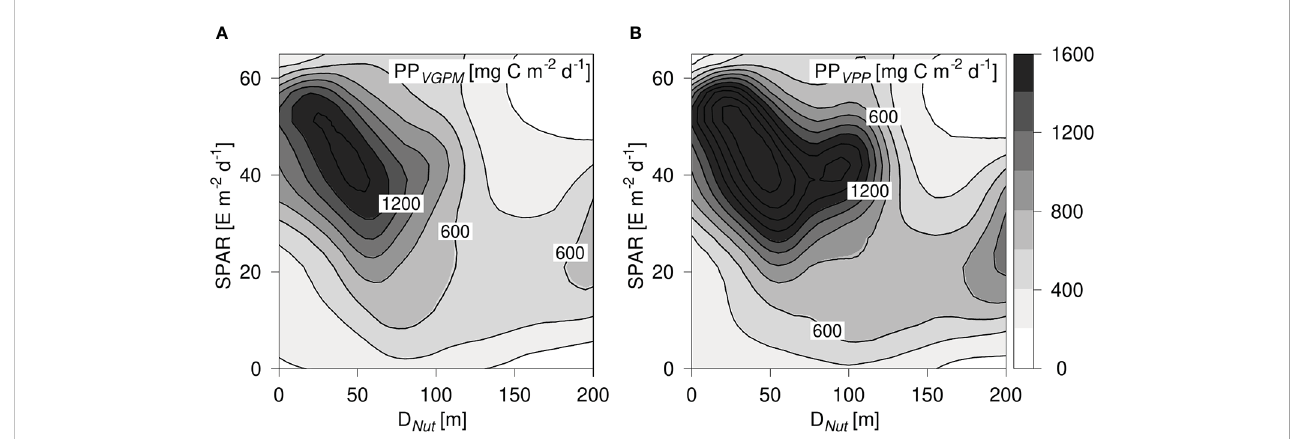
FIGURE 7 (A) PP-diagram of primary production calculated from PP VGPM and, (B) PP VPP . PP is shown versus the corresponding nutricline depth (D Nut ) calculated from Argo-pro fi les and daily averaged Photosynthetic Available Radiation at the surface (SPAR) obtained from satellite observations. Contours are shown in intervals of 200 mg C m -2 d -1